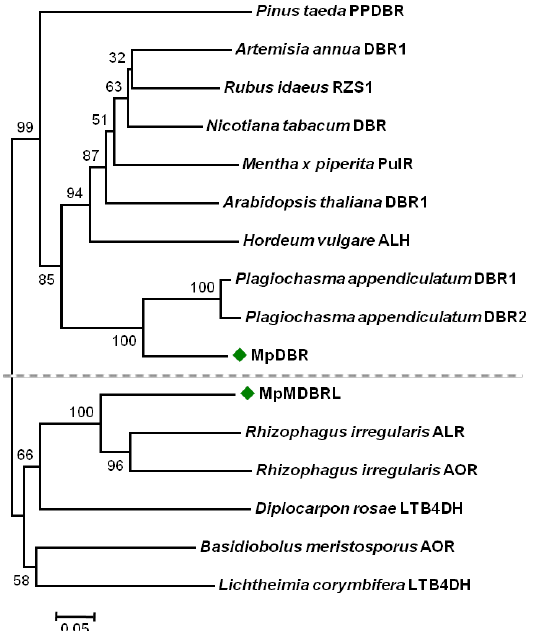
Figure 2. The phylogenetic analysis of MpDBR and MpMDBRL and other double bond reductase proteins from plants and microbes. The scale indicates evolutionary distance. The numbers shown are bootstrap values, based on 1000 replicates.